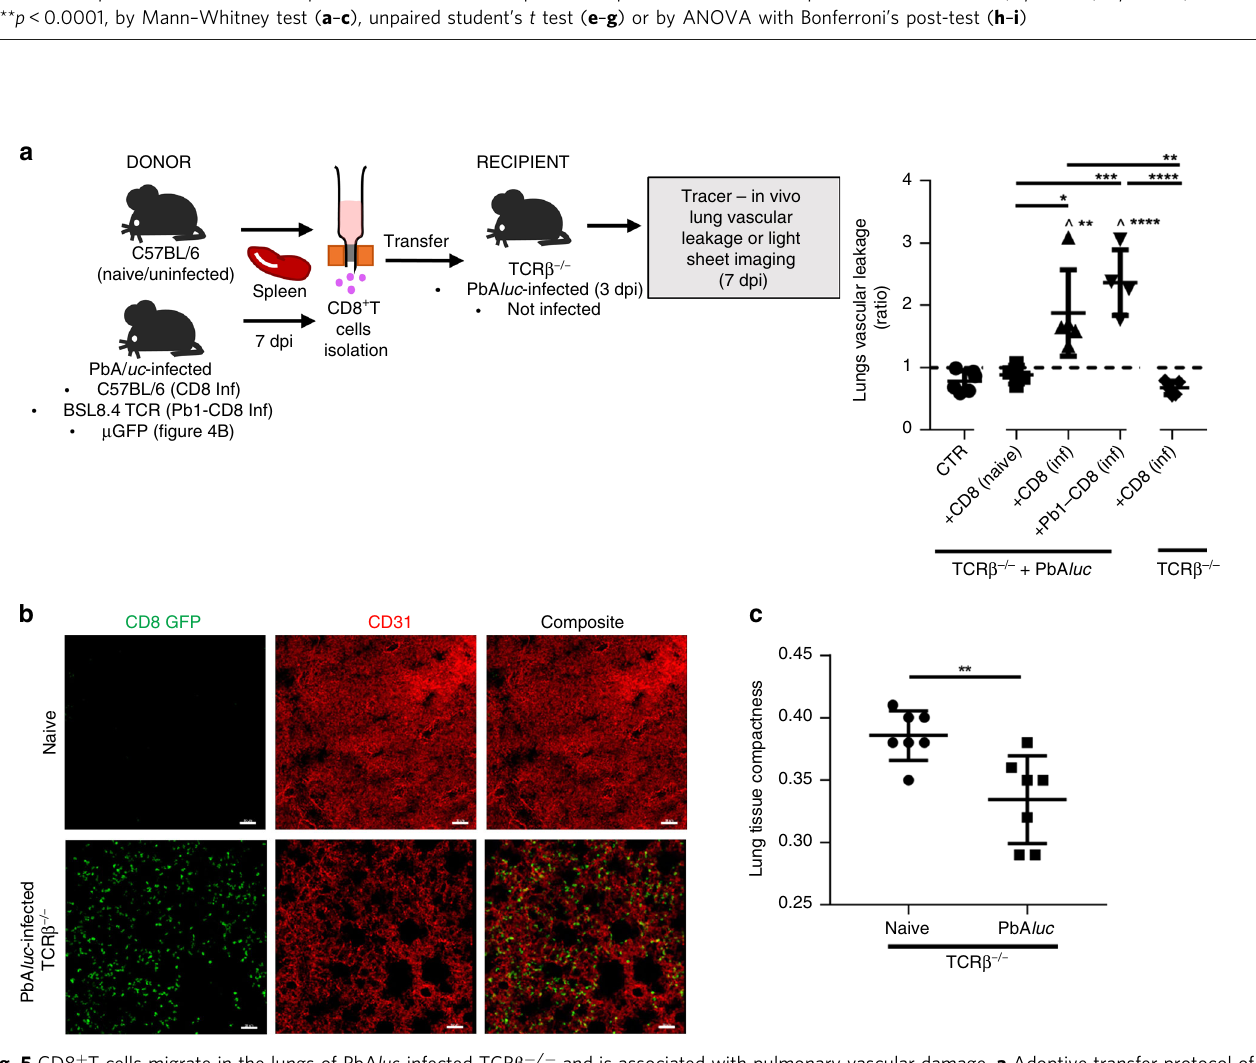
Fig. 5 CD8 + T cells migrate in the lungs of PbA luc -infected TCR β − / − and is associated with pulmonary vascular damage. a Adoptive transfer protocol of CD8 + T cells. Splenocytes were isolated from PbA luc -infected C57BL/6 mice at 7 dpi and CD8 + T cells were isolated and enriched by negative selection using magnetic bead-based cell sorting. Puri fi ed CD8 + T cells (with at least 95% purity) were transferred to PbA luc -infected TCR β − / − mice on 3 dpi. Pulmonary vascular leakage was assessed 4 days post CD8 + T cell transfer. The ratio of in vivo lungs vascular leakage was measured by Tracer-653 dye in PbA luc -infected TCR β − / − (CTR, did not receive CD8 + T cells) mice ( n = 6); PbA luc -infected TCR β − / − mice that were adoptively transferred with enriched CD8 + T cells isolated from the spleen of naïve C57BL/6 ( + CD8 (naive)) ( n = 4), 7 dpi PbA luc -infected C57BL/6 ( + CD8 (inf)) mice ( n = 5), 7 dpi PbA luc - infected BSL8.4 TCR transgenic mice ( + Pb1-CD8 (inf)) ( n = 4); and naïve TCR β − / − that received CD8 + T cells from 7 dpi PbA luc -infected C57BL/6 mice ( n = 5). The data represent the mean ± SD; * p < 0.05, ** p < 0.01, *** p < 0.001, **** p < 0.0001, ^ statistically signi fi cant compared to CTR ( p < 0.05) by ANOVA with Bonferroni ’ s post-test. The black dashed line at y = 1 in ( a ) represents the ratio of tracer reading from naïve mice ( n = 3). b Confocal imaging of cleared lungs of naïve and PbA luc -infected TCR β − / − mice that have received CD8 + T cells isolated from µ GFP mice at 7 dpi and stained with anti-GFP, which indicates CD8 + T cells (green). Scale bar = 50 mm. c Lung tissue compactness was quanti fi ed as a ratio of volume of CD31 mask (from ( b )) to the total volume of selected region of interest. The data are representative of two mice and represent the mean ± SD; ** p < 0.01 by unpaired student ’ s t